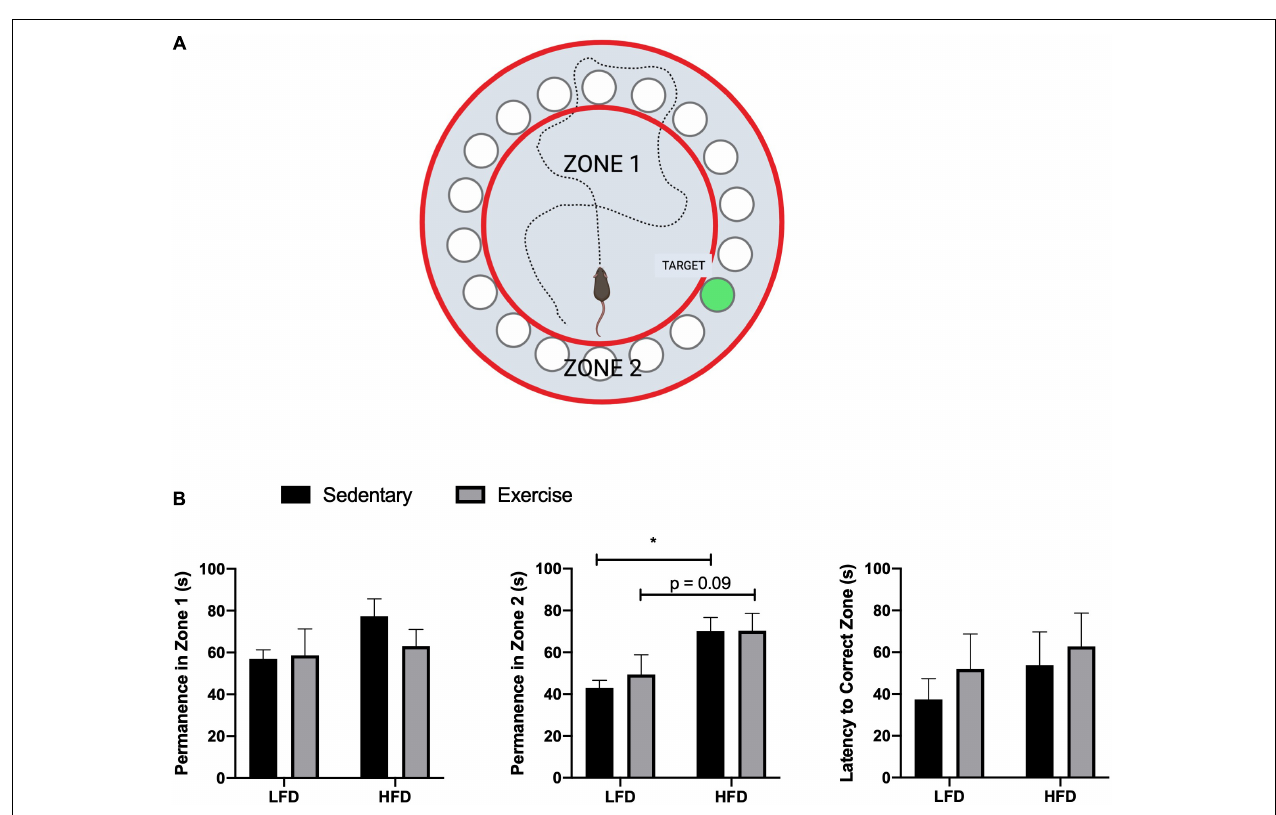
FIGURE 3 | Barnes maze results. (A) Representative image of Barnes maze, zones, and target, created with Biorender. (B) Permanence time in Zone 1, Zone 2, and Latency time to the correct Zone. Values are represented as mean ± SEM. Significance indicated by * p < 0.05 compared to